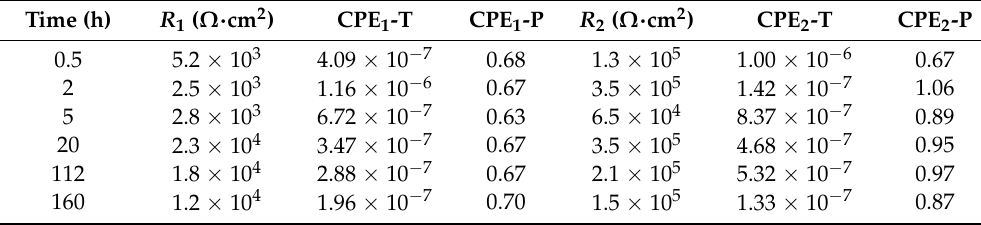
Table 4. Fitting results of EIS plots of the ZrO 2 coating on AZ31 magnesium alloy.